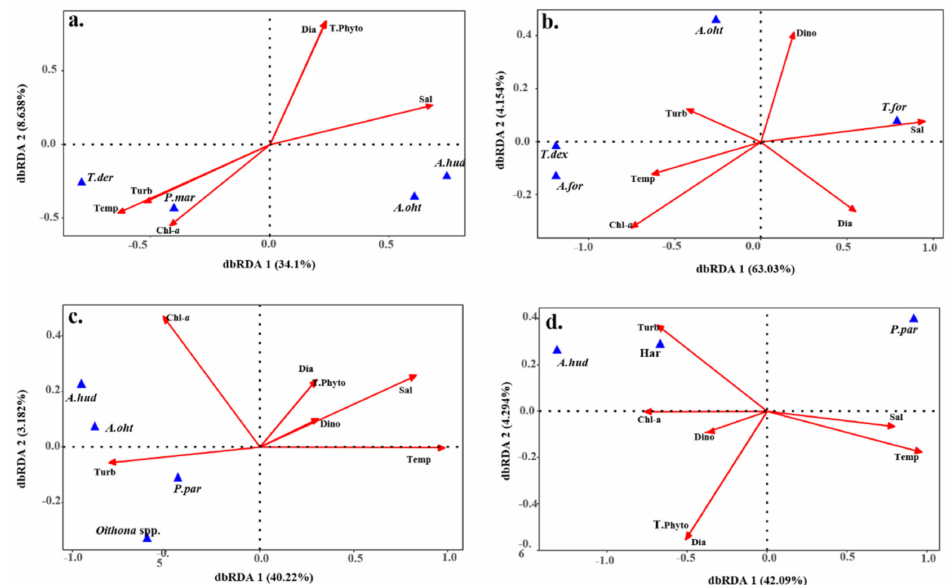
Figure 10. Redundancy analysis (RDA) ordination plot of axes I and II showing major copepods in relation to environmental variables in Doam Bay: ( a ) spring, ( b ) summer, ( c ) fall, ( d ) winter. Abbrevi- ations: A.for , Acartia forticrusa ; A.hud , Acartia hudsonica ; A.oht, Acartia ohtsukai ; P.mar , Pseudodiaptomus marinus ; P.par , Paracalanus parvus s. l.; T.der , Tortanus derjugini ; T.dex , Tortanus dextrilobatus ; T.for , Tortanus forcipatus ; Har, Harpacticoida; Chl-a, Chlorophyll- a concentration; Dia, Diatomeae; Dino, Dinoflagellata; Phyto, Phytoplankton; Sal, Salinity; Temp, Temperature; Turb,